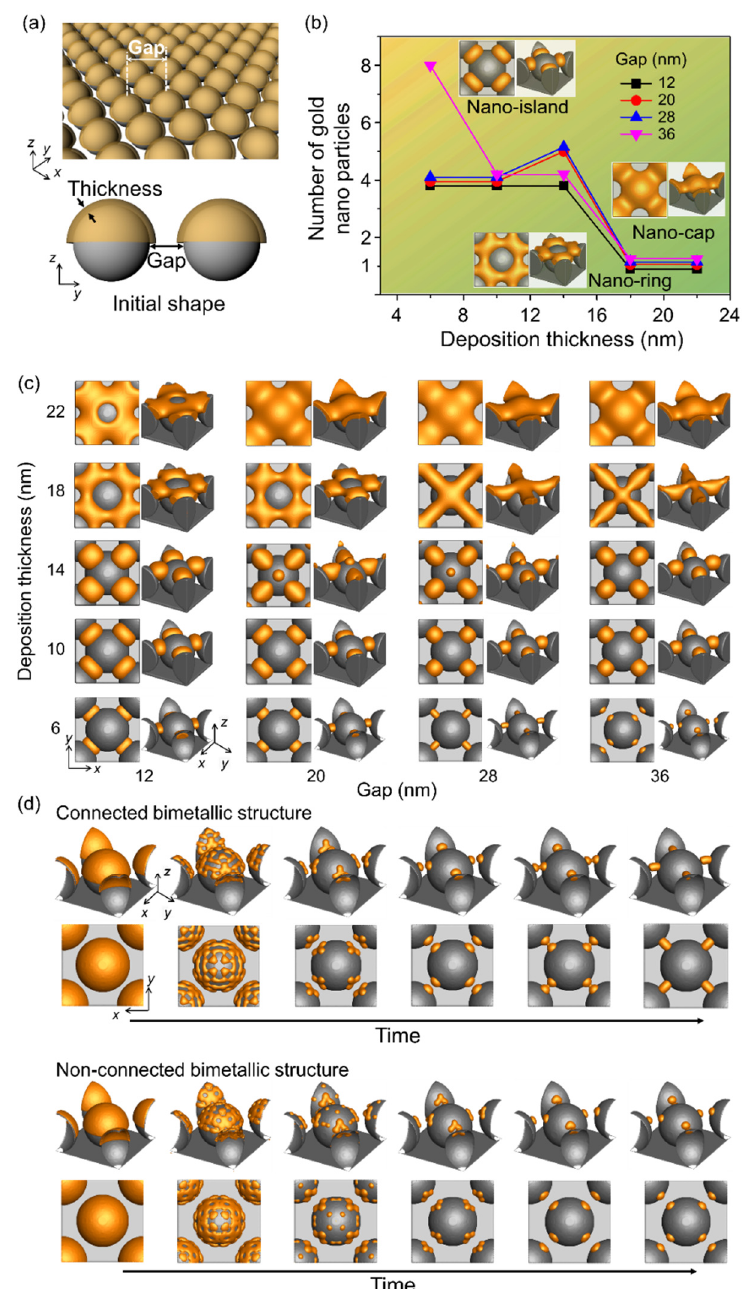
Figure 3. Effects of the gap between the patterned substrate and the deposition thickness on the equilibrium structure in thermal dewetting. ( a ) Schematic of the simulation considering the gap between the patterns in substrate and deposition thickness. ( b ) Number of gold nanoparticles formed by thermal dewetting with varying deposition thickness and gap. The yellow area corresponds to the formation of nano-island, and the green area denotes the absence of nano-ring and nano-cap between the gaps. ( c ) Equilibrium morphologies of bimetallic nanostructures after thermal dewetting with respect to gap and thickness. ( d ) Time-dependent structural evolution of gold nanoparticles that are connected or not connected to the substrate patterns.